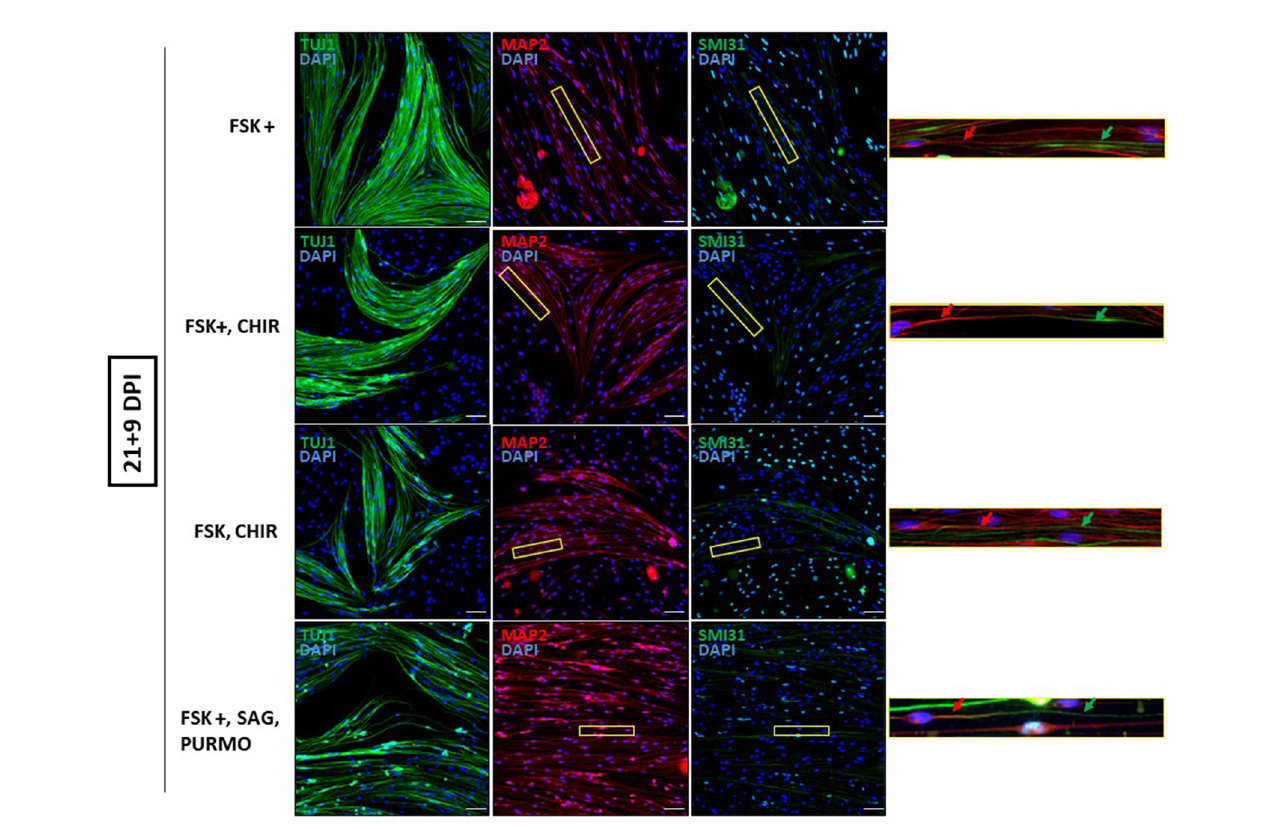
FIGURE5 Mature neuronal marker expression in reprogrammed OEG-ROB cells. Removing the medium with small molecules at day 21 and adding differentiation medium until day 30, allowed an increase in cell survival together with the development of an elongated shape and cell aggregation into bundles. Reprogrammed OEG-ROB cells not only expressed proneural markers Tuj1 (green) and MAP2 (antibody 514 against MAP2A&B) (red) but also SMI31 in MAP1B and neurofilament H proteins (green), which is a component of mature axons and is characteristically expressed in a gradient manner, as can be observed in the figure enlargements: red arrows show MAP2 expression while green arrows highlight SMI31 expression more distally in the same cell axon. Nuclei were stained with DAPI (blue). DPI, days post-induction; FSK, forskolin 10 µ M; FSK + , forskolin 20 µ M; CHIR, CHIR99021 1.5 µ M; SAG, smoothened agonist 0.2 µ M; Purmo, purmorphamine 0.2 µ M; Scale bar: 50 µ